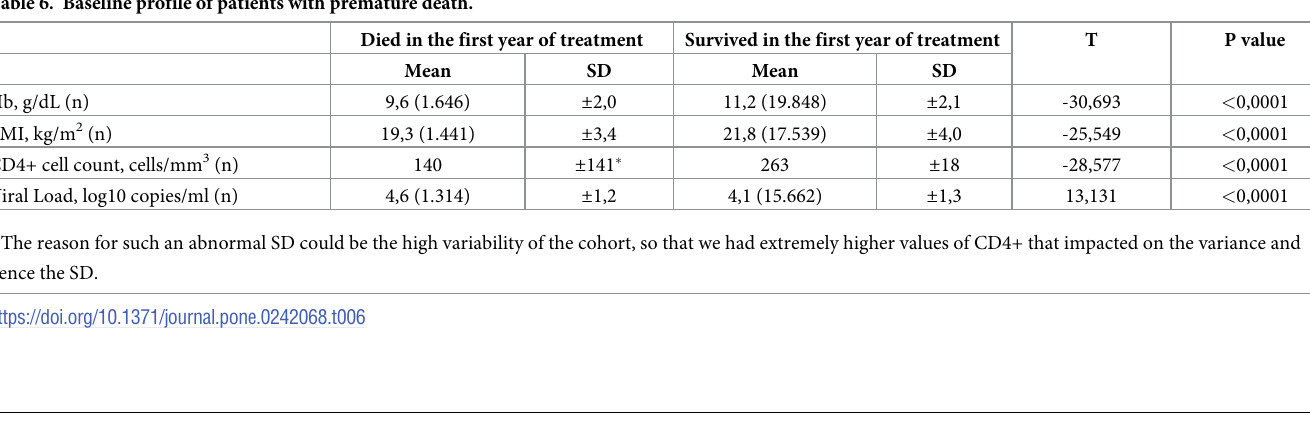
In addition, data for patients with an RBC count over or under the median value of 4,2 mil- lion/mm 3 were analysed. The risk of premature death for patients with lower RBC increased by nearly 10% compared to patients with higher baseline RBC (Fig 3). Also, MCV values influ- enced early mortality (Fig 4): patients with lower MCV at enrolment showed a slightly increased risk of premature death (HR 1.146; 95%CI 1.017–1.291). Fig 5 shows the survival curves of patients with different Plt counts, independent of CD4+ count, BMI and VL. The probability of survival at one year for patients with a Plt count higher than the median value (230 x 10 9 /l) was slightly but significantly lower than for those with a Plt count under the median value.